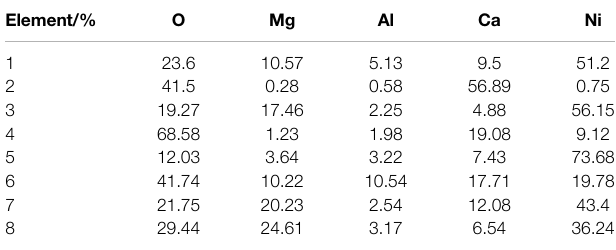
TABLE 3 | EDS of Mg doped catalysts.